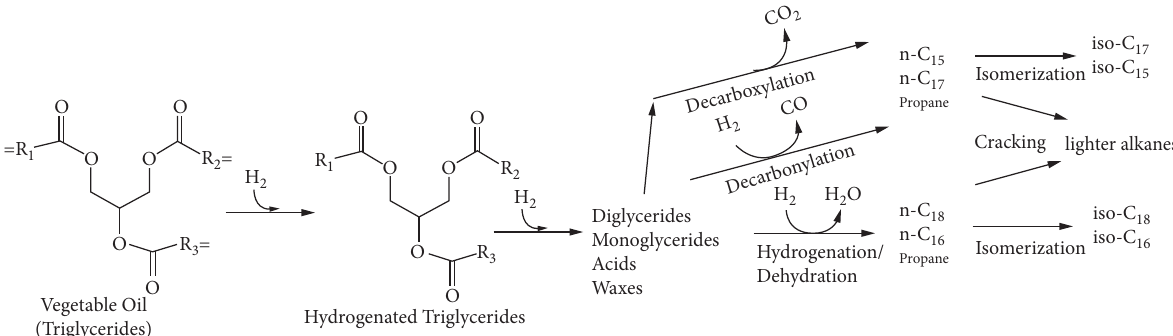
Figure 1: Reaction scheme for converting triglycerides to hydrocarbons. Source: Huber et al.